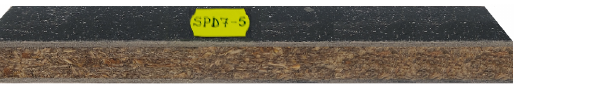
Figure 3. Sandwich composite test specimen with D7 hybrid resin matrix, which has a chopped wheat straw core and flax fabric faces, used for flexural test (in 3